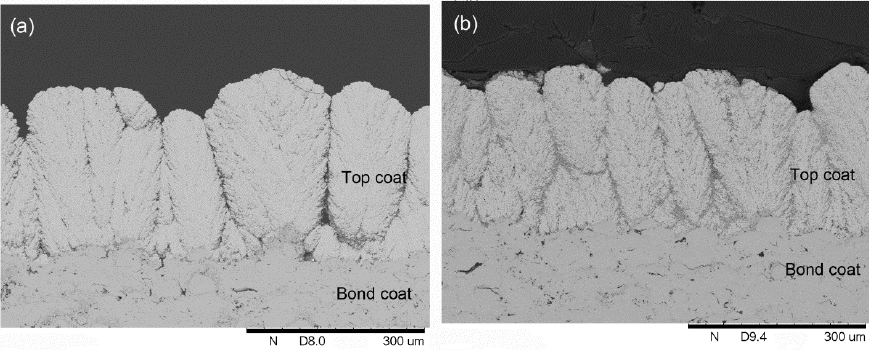
Figure 6. Cross ‐ section images of as ‐ sprayed YSZ top coats (Samples K ( a ) and L ( b )) sprayed with 5 Figure 6. Cross-section images of as-sprayed YSZ top coats (Samples K ( a ) and L ( b )) sprayed with wt % solid content suspension on as ‐ sprayed BC. 5 wt % solid content suspension on as-sprayed